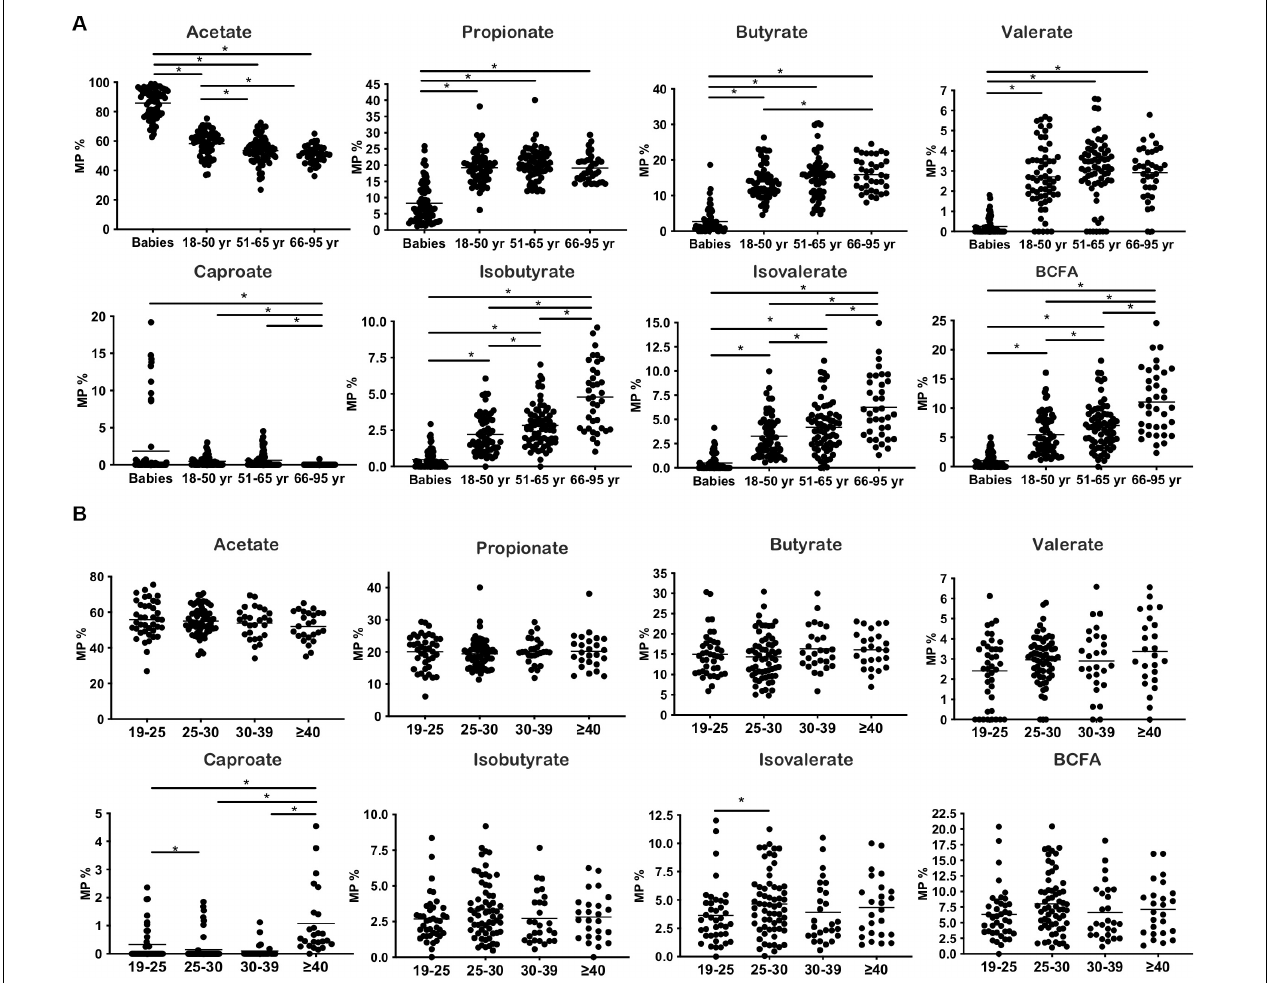
FIGURE 1 | Changes in SCFA production throughout life and BMI increases. (A) Molar proportions of SCFA during aging. (B) Molar proportions of SCFA throughout BMI increases. * p <